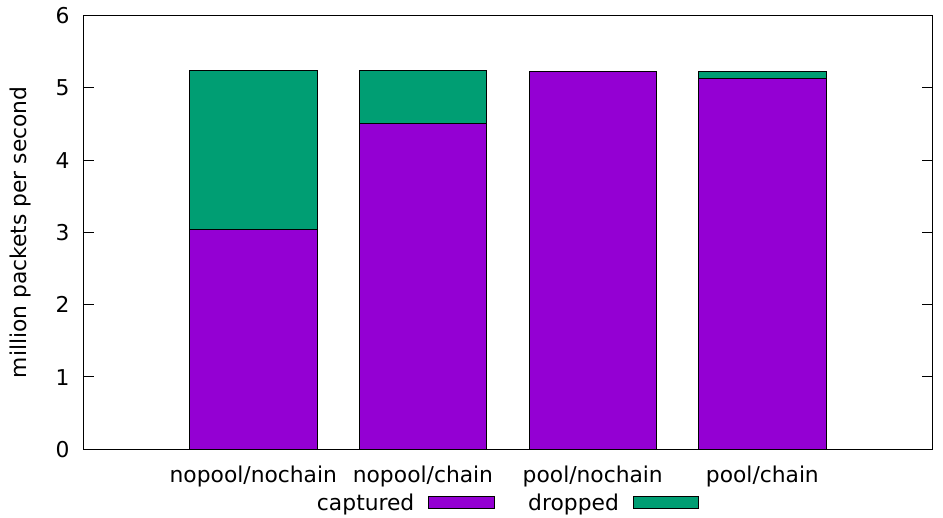
Figure 8. Evaluation on real-traffic replayed at 20 Gb/s from a pcap file. Application is run with SOURCE and SINK operators